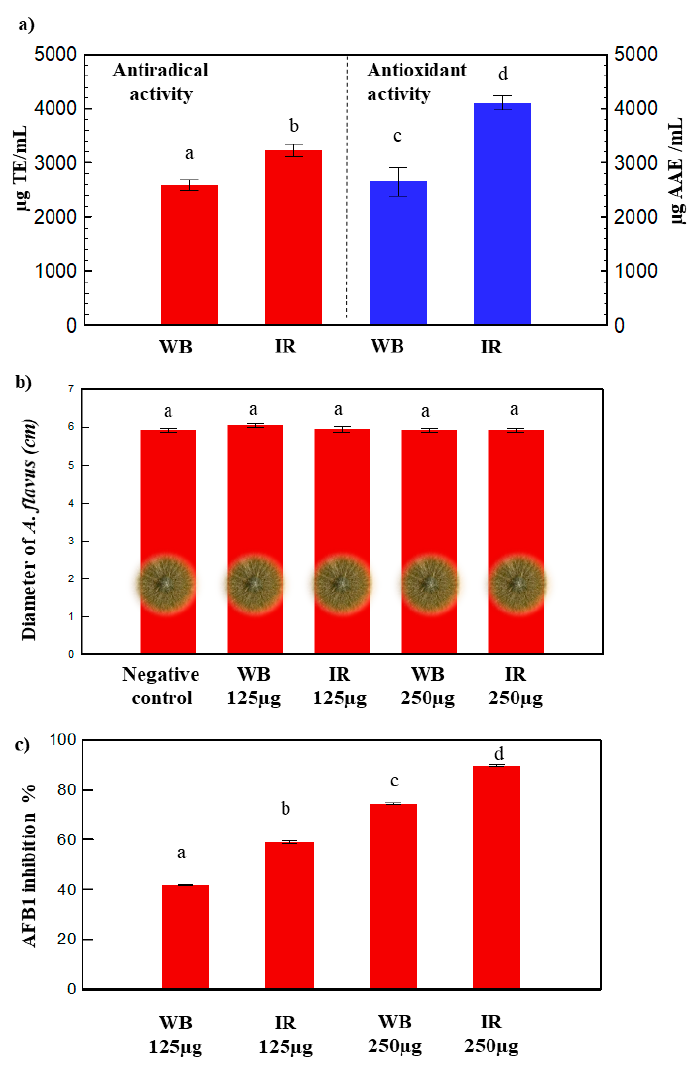
Figure 4. ( a ) Antiradical and antioxidant activities, ( b ) fungal growth of A. flavus and ( c ) AFB1 inhibition percentage for WB and IR extracts (a, b, c, and d indicate significant statistical di ff erence between